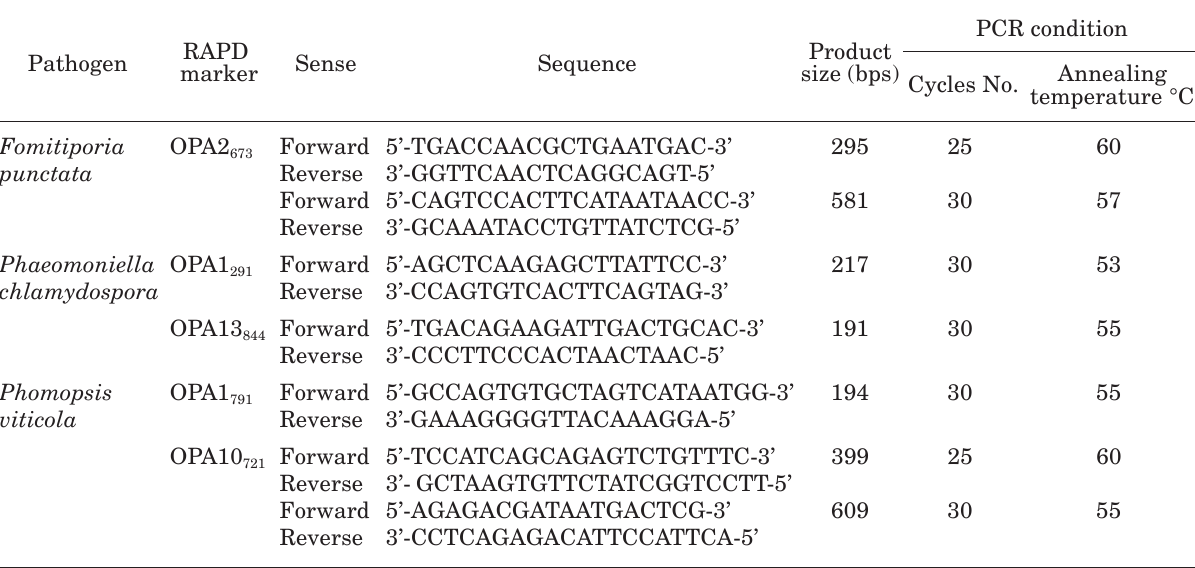
Table 1. SCAR primers and PCR amplification